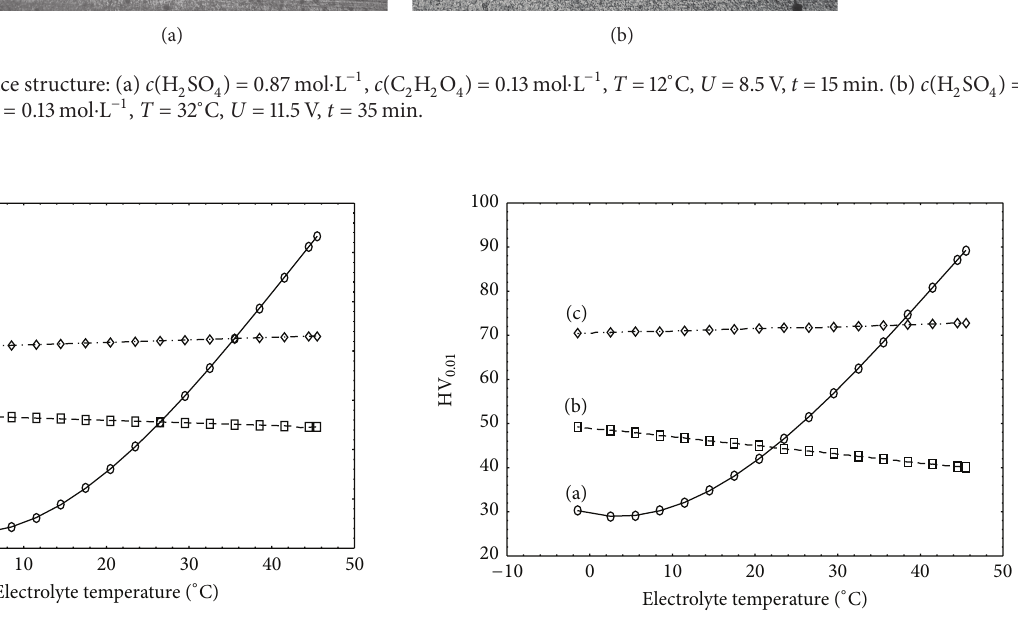
Figure 5: The dependence of the layer microhardness on the tem- perature of the electrolyte: c (H 2 SO 4 ) = 1.43mol ⋅ L −1 , c (C 2 H 2 O 4 ) = 0.06 mol ⋅ L −1 , U = 10V, t = 15min. (a) 1A ⋅ dm −2 , (b) 3A ⋅ dm −2 , and (c) 5 A ⋅ dm −2